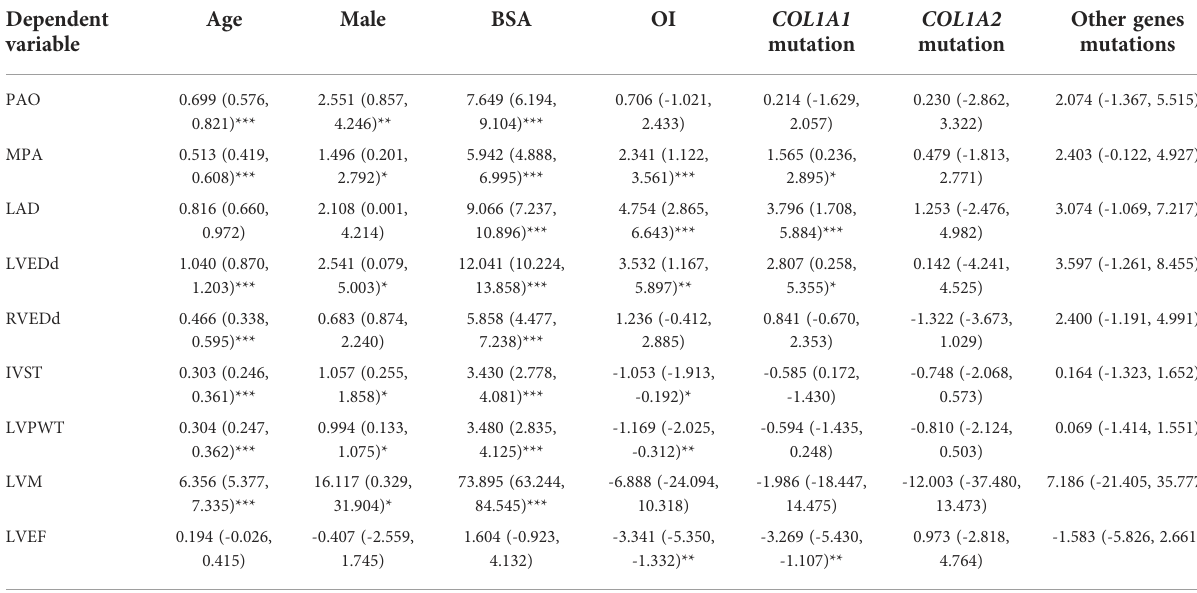
TABLE 5 Factors associated with echocardiographic